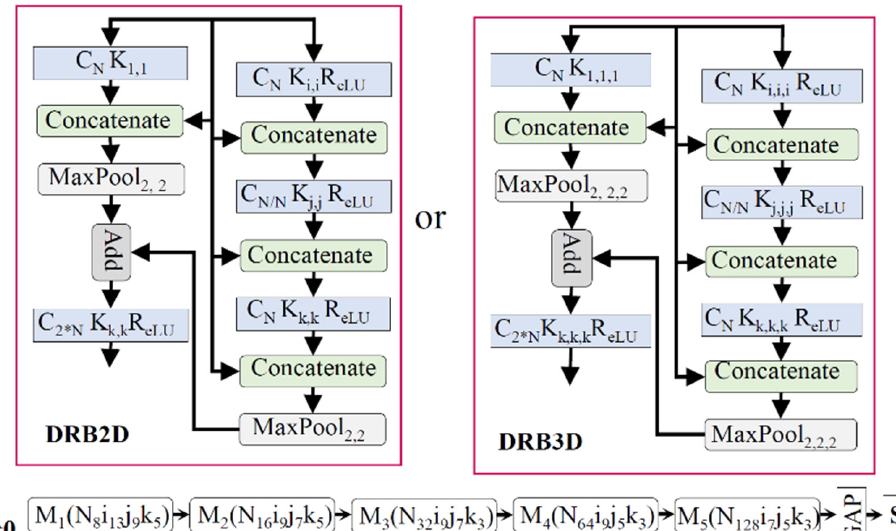
Figure 3. The block diagram of the proposed music video emotion classification network A 0 with the 2D/3D convolution. The acronyms DRB2DSC and DRB3DSC are detailed views of the dense residual block with the standard 2D and 3D convolution for the music network and the video/face network, respectively. The symbol A represents the network architecture, M represents the dense residual block defined in the detailed view, S represents the Softmax function, GAP is global average pooling, and MMTM is the multimodal transfer module. Similarly, the symbols N, i, j, and k with values in the lower case represent the values of the items, as illustrated in the respective detailed views.